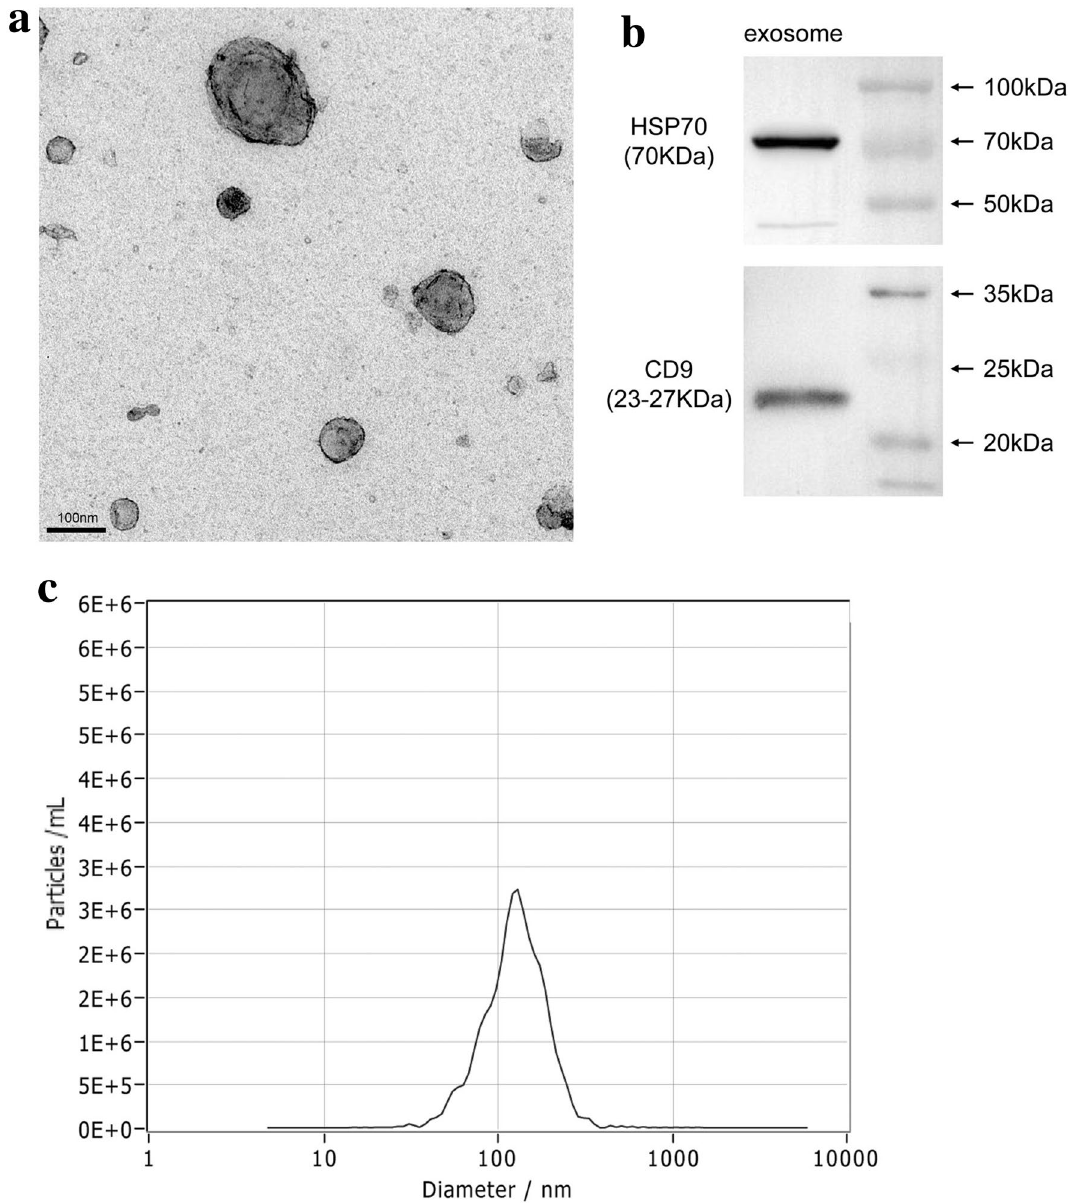
Figure 1. Identification of hBMSC-derived exosomes. ( a ) Identification of morphological characteristics of hBMSC-derived exosomes by transmission electron microscopy. The exosome concentrations were 1.5 to 1.6 × 10 9 /ml. ( b ) Western blot demonstrated characteristic markers of hBMSC-derived exosomes: HSP70 and CD9. ( c ) Size distribution of exosomes with a ZetaView analysis